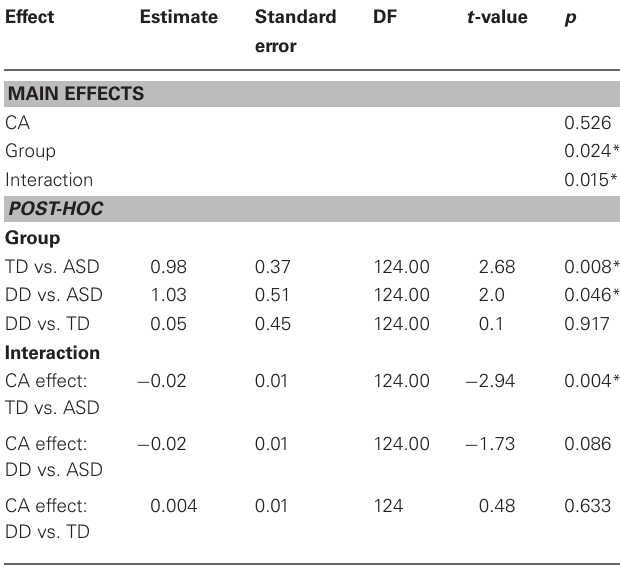
Table 5 | Time to peak grip force and chronological age